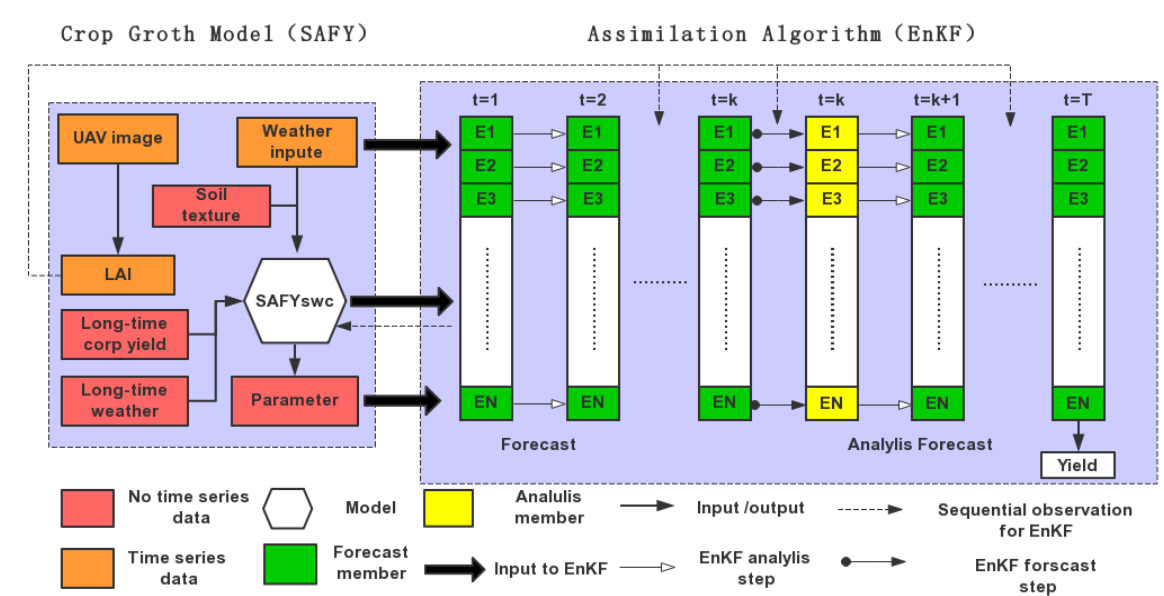
Figure 4. Schematic of the data assimilation and technical processes framework.